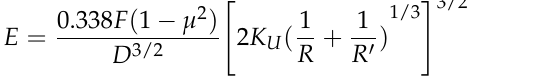
Figure 3. The force – deformation relationship of SN42 soybean seeds when the deformation is